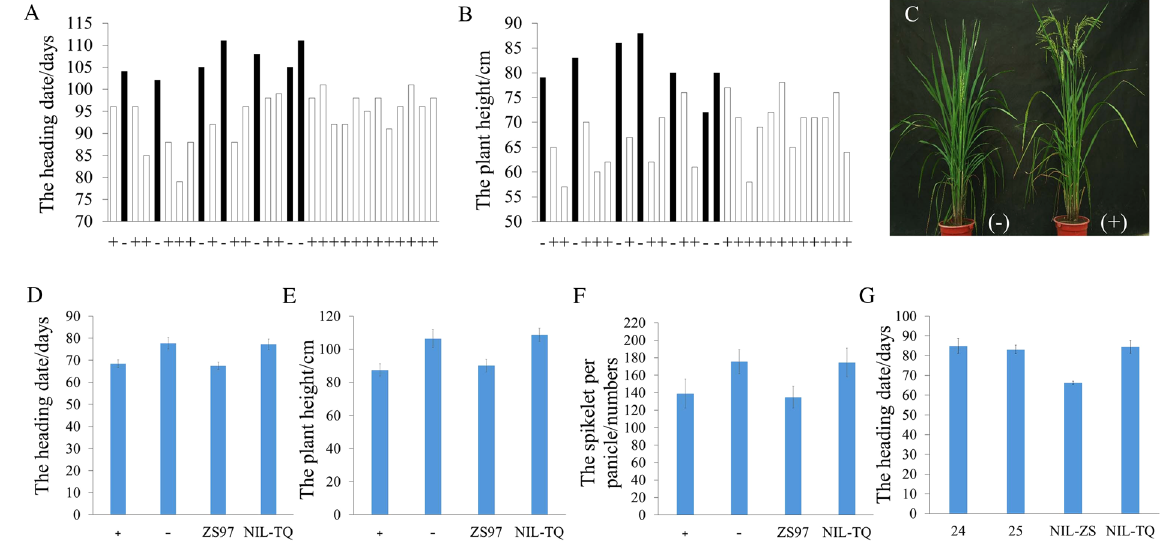
Figure 2. Phenotypes of Hd1 transformation plants. ( A ) The heading date of T1 individuals from T0 plant 85 by transforming ProHd1:Hd1:GFP into NIL-TQ; ( B ) The plant height of T1 individuals from T0 plant 85; ( C ) a picture for homozygous positive and negatives T2 plants from T0 plant 85; ( D ) the heading date of T2 plants by selfing 85; ( E ) the plant height of T2 plants by selfing 85; ( F ) the spikelet per panicle of T2 plants by selfing 85; ( G ) the heading date of Hd1 knock out plants 24 and 25 in T1 generation. “ + ” and “ − ” means the positive and negative transformed plants, respectively.